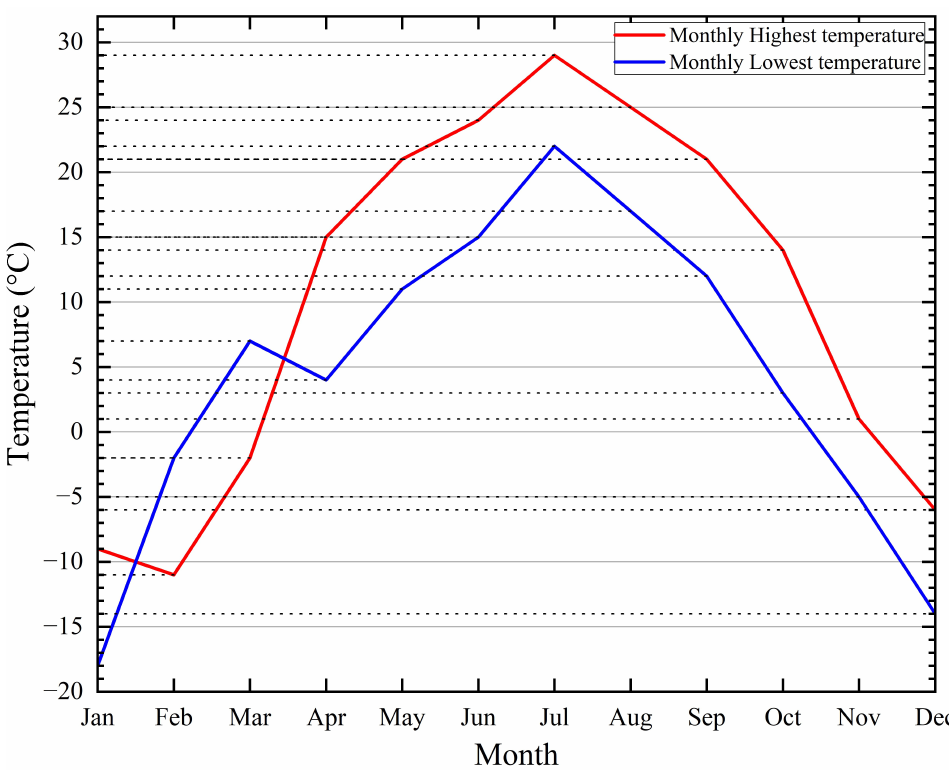
Figure 10. Annual average temperatures in the Changchun Jingyue Development Zone for